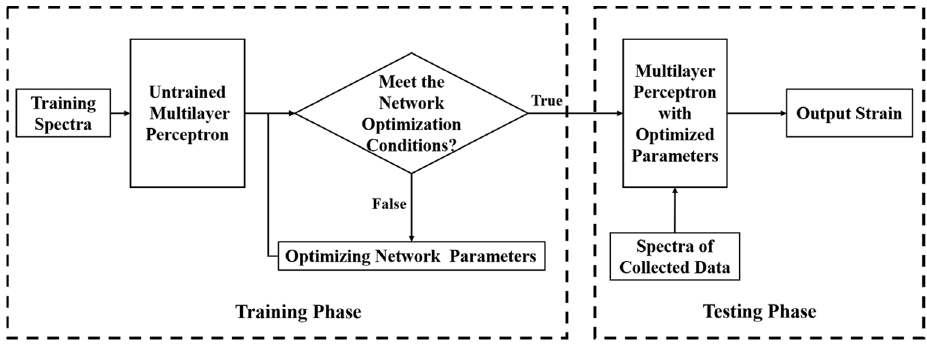
Figure 2. Schematic diagram of training phase and testing phase of multilayer perceptron.